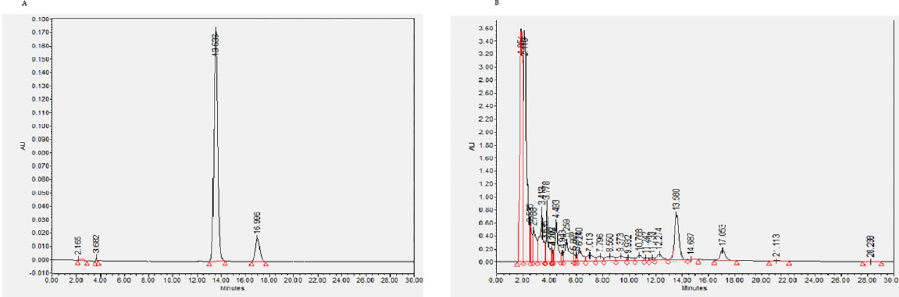
Fig 1. The contents of Epimedin C and Icariin in XLGB powder were determined by HPLC. A. HPLC chromatograms of the reference substance of Epimedin C and Icariin B. HPLC chromatograms of XLGB powder. 1. Epimedin C, 2.